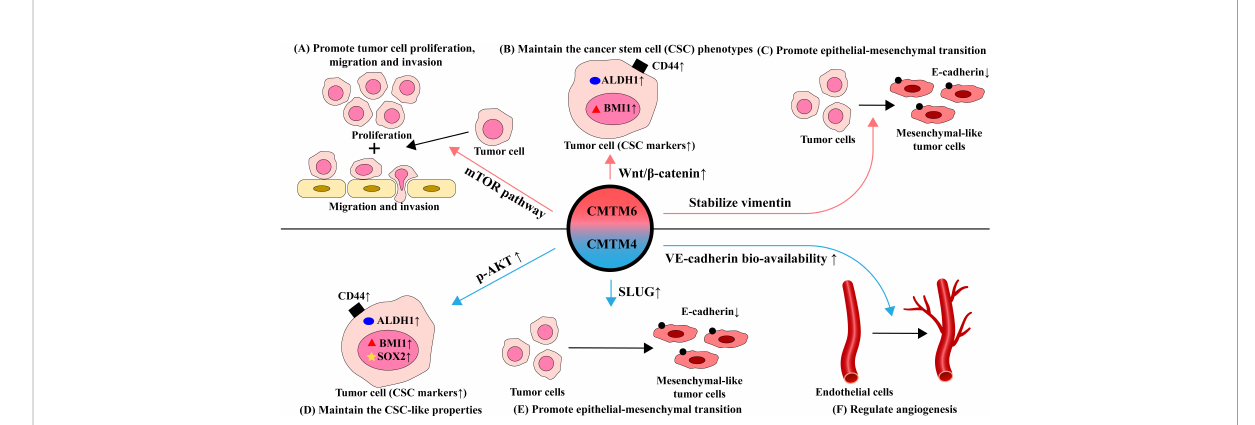
FIGURE 2 Effects and mechanisms of CMTM6 and CMTM4 in regulating the function of tumor and endothelial cells in TME. (A) CMTM6 promotes tumor proliferation, migration and invasion by activating the mTOR pathway. (B) CMTM6 maintains stem cell-like properties through affect Wnt/ b - catenin signaling pathway, mainly manifested by elevated expression of several CSC-related markers such as CD44, ALDH and BMI1. (C) CMTM6 induces epithelial-mesenchymal transition (EMT) by stabilizing vimentin, which behaved as the E-cadherin decreased. (D) CMTM4 positively affected CSC-like properties via the AKT pathway, mainly manifested by signi fi cantly elevated expression of CSC markers (CD44, ALDH1, BMI1, and SOX2). (E) CMTM4 promotes EMT through positive regulation of SLUG. (F) CMTM4 plays an important role in regulating angiogenesis by enhancing the bio-availability of VE-cadherin at cell-cell adherens junctions and promoting endothelial barrier